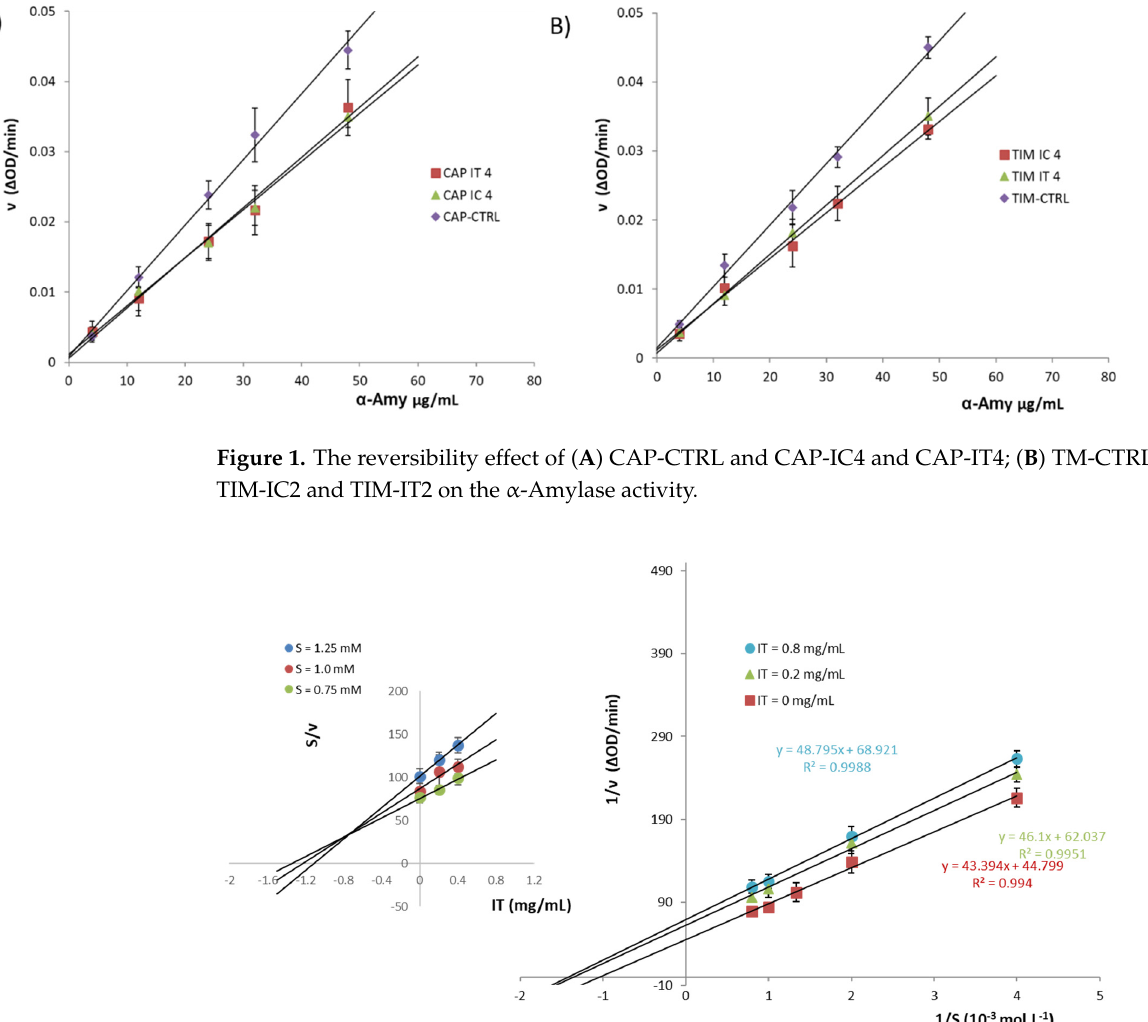
Figure 3. Lineweaver-Burk (L-B) of α -Amylase in presence of commercial inulin (IC). The insets depict the secondary plots to determine the kinetic constants. Linear relationships between 1/v and 1/S were observed in the plots. L-B plot ob- tained for IT indicated an un-competitive inhibition behavior at increasing concentration of IT (from 0 to 0.8 mg/mL) yielding parallel straight lines (Figure 2). Furthermore, the un- competitive inhibition was corroborated by Cornish-Dowden plot, where the data re- ported as S/v vs. IT concentration gave straight lines crossing in the second quadrant [35]. From the secondary plot, a dissociation constant K ʹ i of 0.76 mg/mL related to the interac- tion of inhibitor (I) with the enzyme-substrate complex (IES) was determined. Conversely, both the slopes ( K m /v max ) and Y-axis intercepts (1/v max ) of curves of IC increased when the IC concentration increased from 0.0 to 0.4 mg/mL (Figure 3). All the curves intersected at the second quadrant, suggesting IC inhibits α -Amylase through a mixed-type mode that is an intermediate mechanism between non-competitive and com- petitive inhibition, agreeing with a previous report [35]. The secondary plots of the L-B graphic gave the K ʹ i and K i values, thus confirming the above-described mechanism.